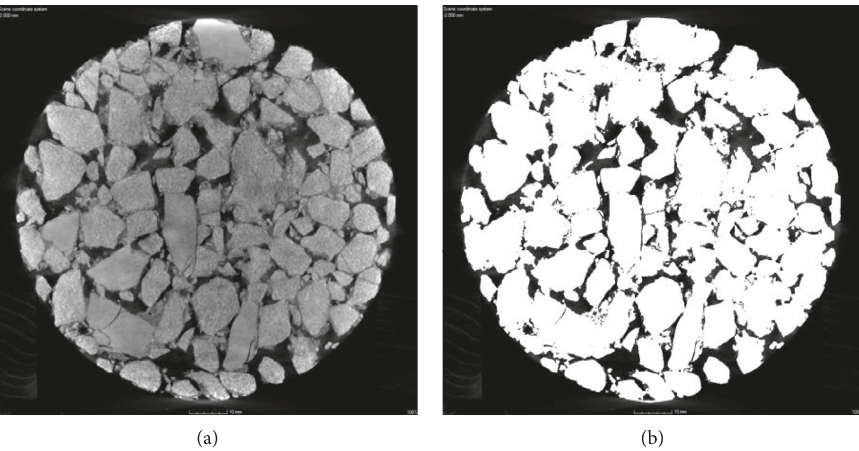
Figure 2: An example for X-ray CT image analysis using VG Studio Max ® 2.2.2 software: (a) original grayscale image; (b) binary